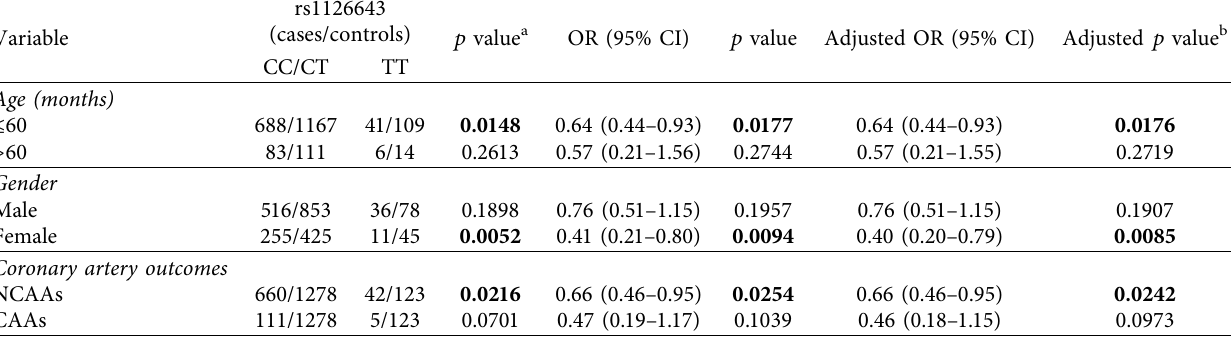
Table 4: Stratification analysis of platelet glycoprotein Ia/IIa C807T(rs1126643) gene polymorphism in Kawasaki disease cases and healthy controls.